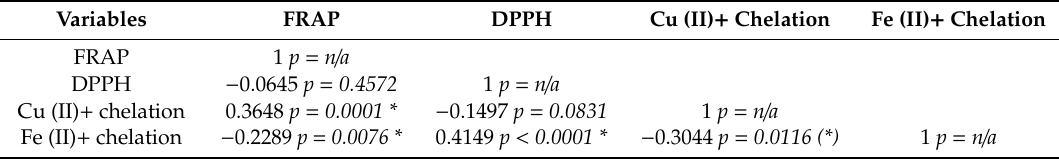
Table 1. Spearman’s correlation ( ρ ) of normal fecal samples.